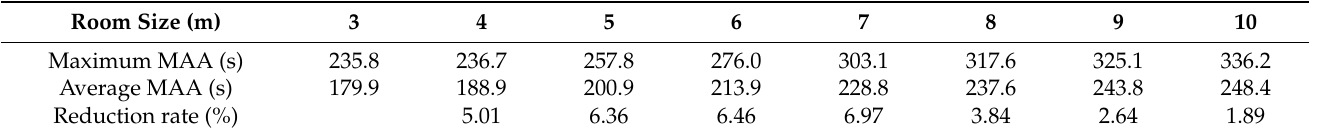
Table 4. Change of MAA with room size.